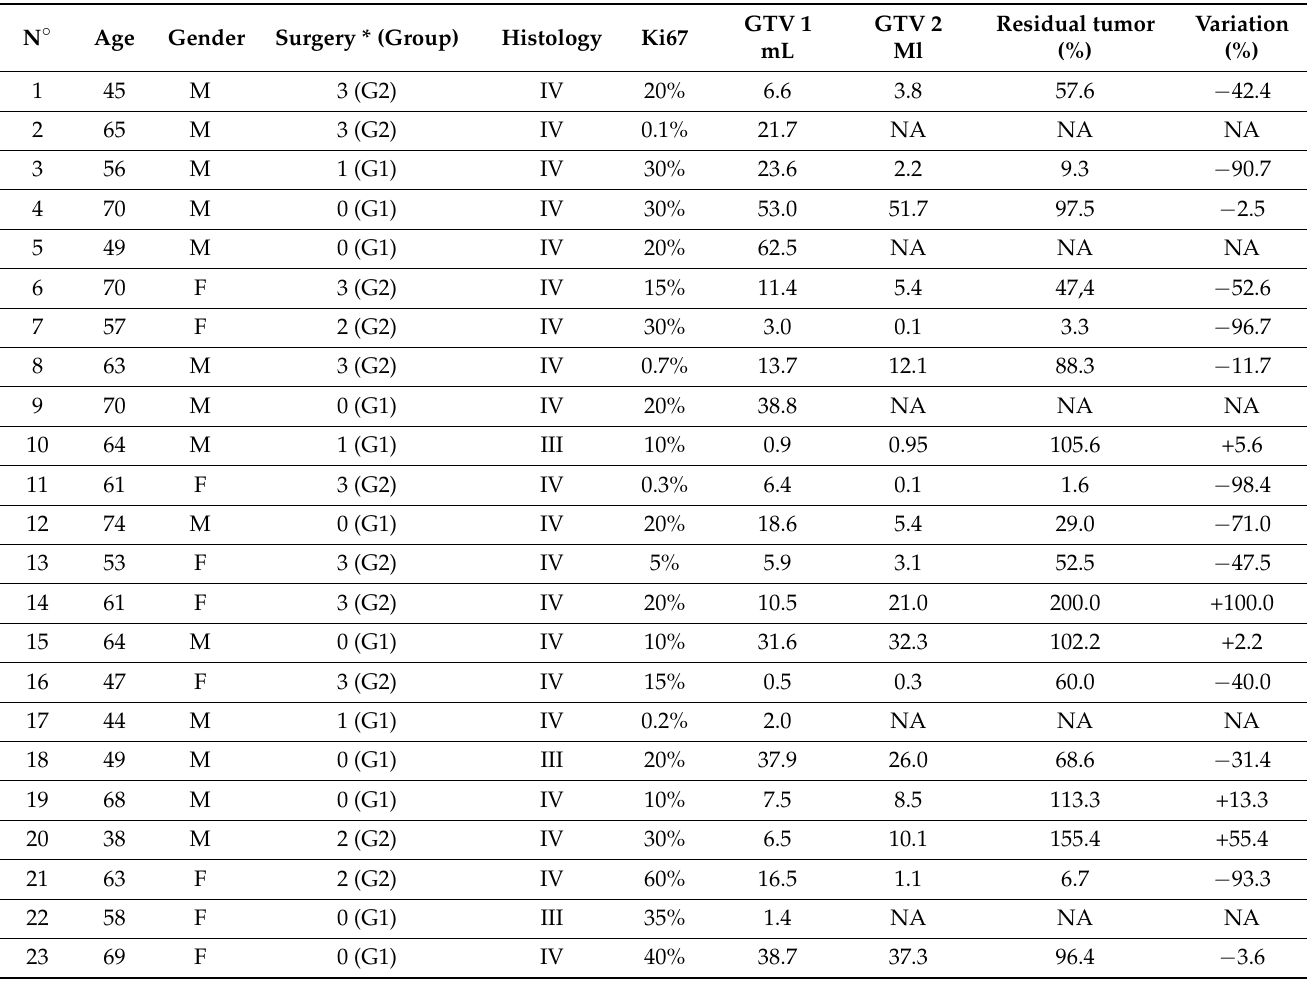
Table 2. Population characteristics and variation in tumor volumes between MRI 1 (GTV 1) and MRI 2 (GTV